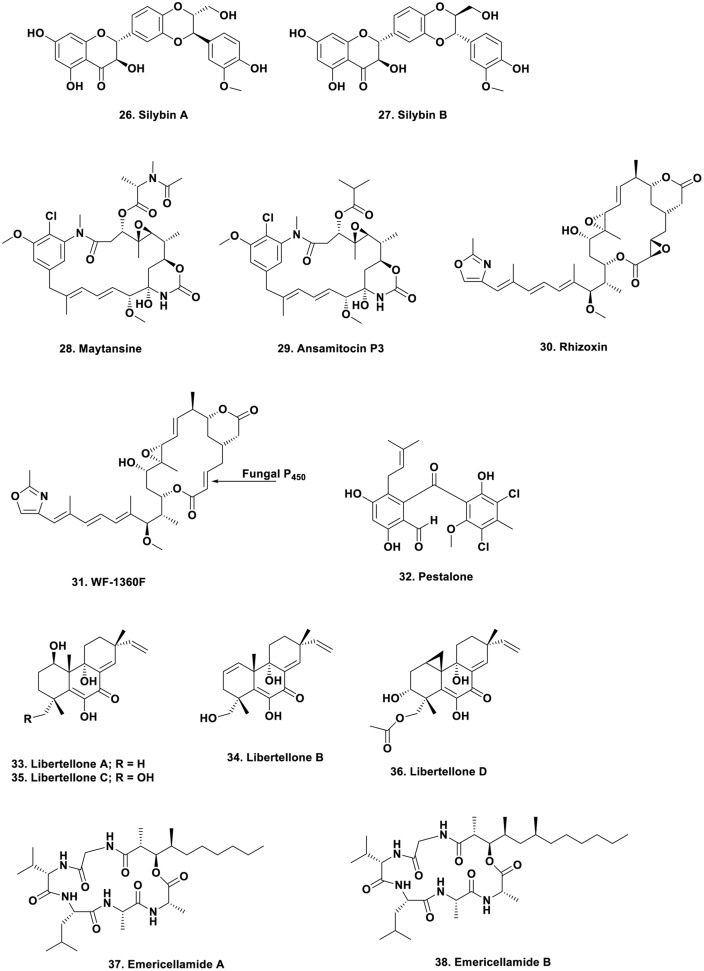
Compounds 26 to 38.